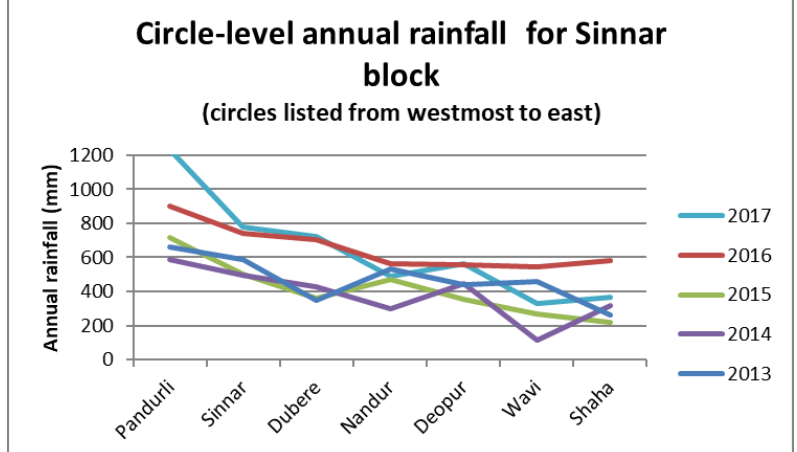
Figure A2.3 Variation of rainfall within Sinnar block as seen from West (high-rainfall region) to East (low rainfall region). The block is divided into seven agricultural circles each of which has a rain-gauge maintained by the agricultural department. Daily rainfall for each circle is available online at